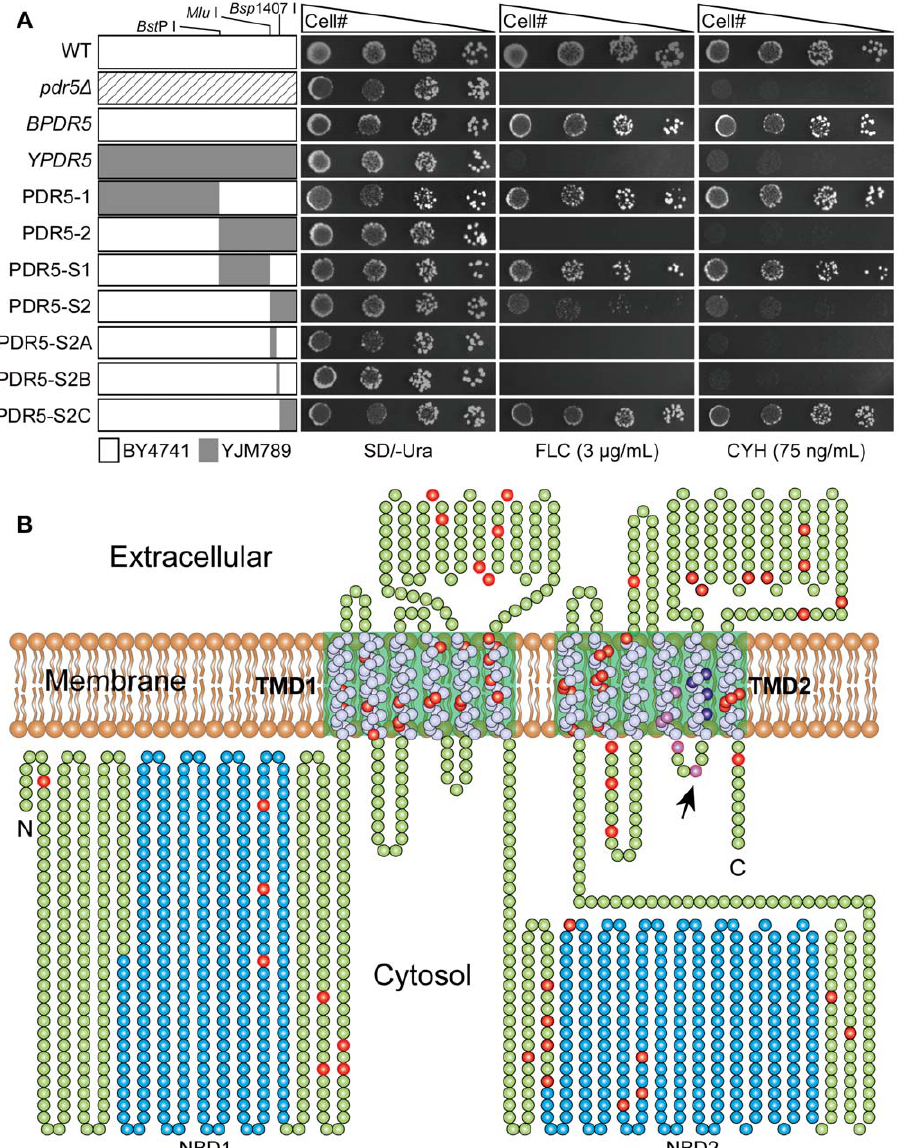
Figure 1. Identification of residues important for Pdr5p function and distribution of mutations in YJM789 Pdr5p. (A) Segmental replacement of BY4741 PDR5 and drug resistance profiles of pdr5 D S. cerevisiae cells expressing wild type and chimeric PDR5s by spot assay. Various regions of BY4741 PDR5 are segmentally replaced by corresponding segments from YPDR5 . Segments from BY4741 and YJM789 PDR5 are shown as white and grey rectangles, respectively. The unique Bsp I, Mlu I, Bsp1407 I restriction sites, which were used to construct PDR5 chimeras are marked. Five-fold serial dilutions of pdr5 D mutant carrying different PDR5 constructs were spotted on SD/-Ura media in the absence and the presence of 3 m g/ mL fluconazole or 75 ng/mL cycloheximide. Plates were incubated for 72 hours at 30 u C. (B) The topological model is based on the molecular modeling study of Pdr5p [11]. Two-dimensional schematic cartoon of Pdr5p shows the 12 predicted membrane spanning helices (white spheres) and two NBDs (blue spheres). The green boxed areas indicate the TMDs. Divergent residues between BY4741 and YJM789 are shown as red, purple and dark blue spheres, respectively. Ala 1352 is indicated by black arrow.